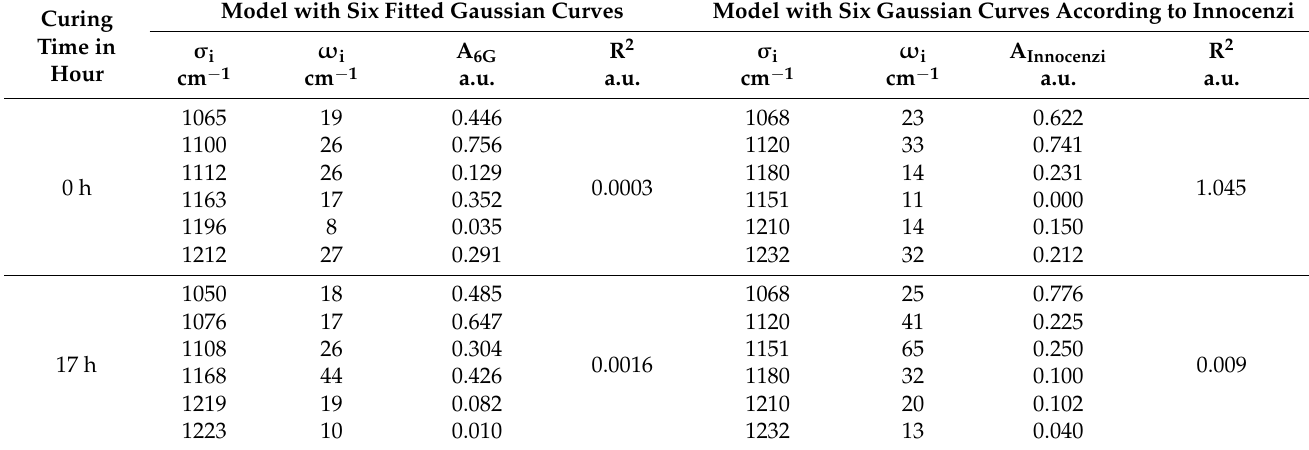
the thicker the layer, the more the peaks shifted towards the lower wavenumber [34]. Table 1. Summary of the difference between a free fit and a fit taking into account the bonding value determined by Innocenzi (see equations 1 and 2 ).